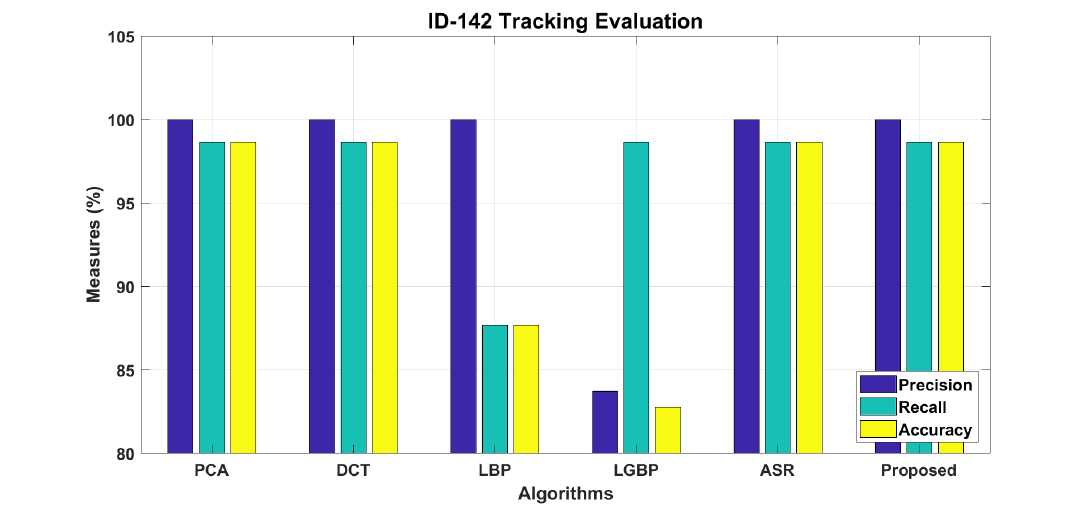
Figure 12. Performance evaluation for identifying and tracking